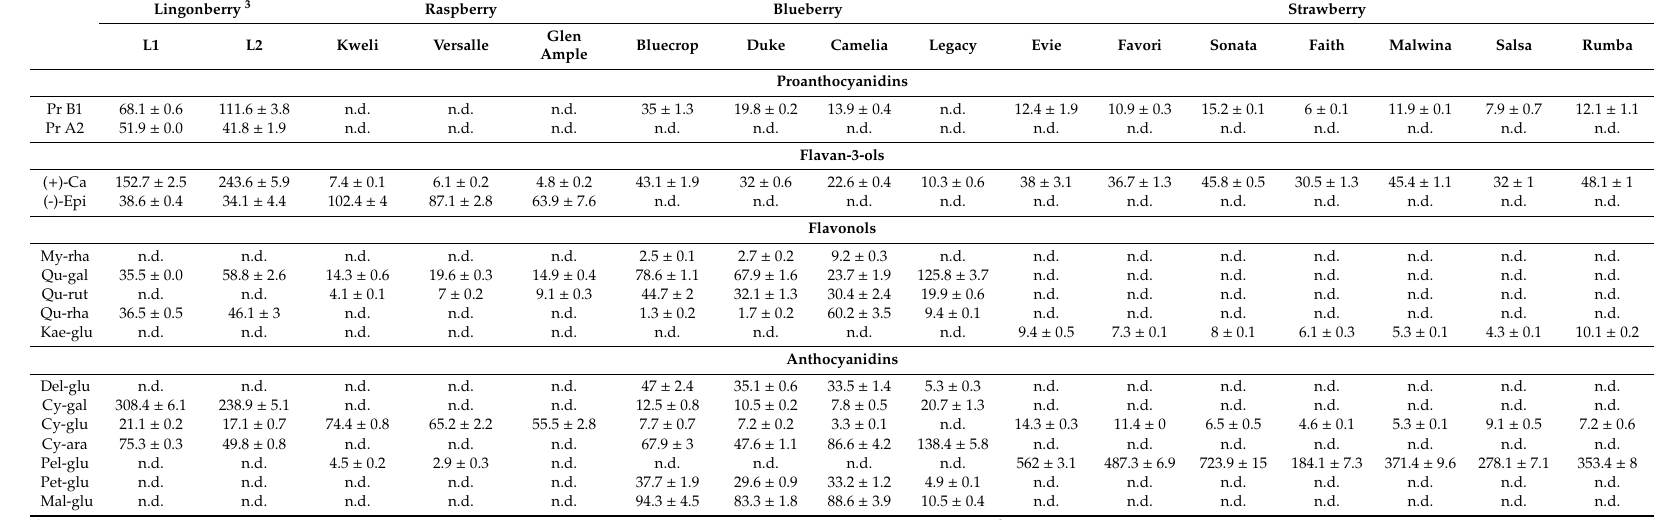
Table 2. Content 1, 2 (mg / 100 g dwt) of individual flavonoids in selected berry varieties. Lingonberry 3 Raspberry Blueberry Strawberry L1 L2 Kweli Versalle Glen Ample Bluecrop Duke Camelia Legacy Evie Favori Sonata Faith Malwina Salsa Rumba Proanthocyanidins